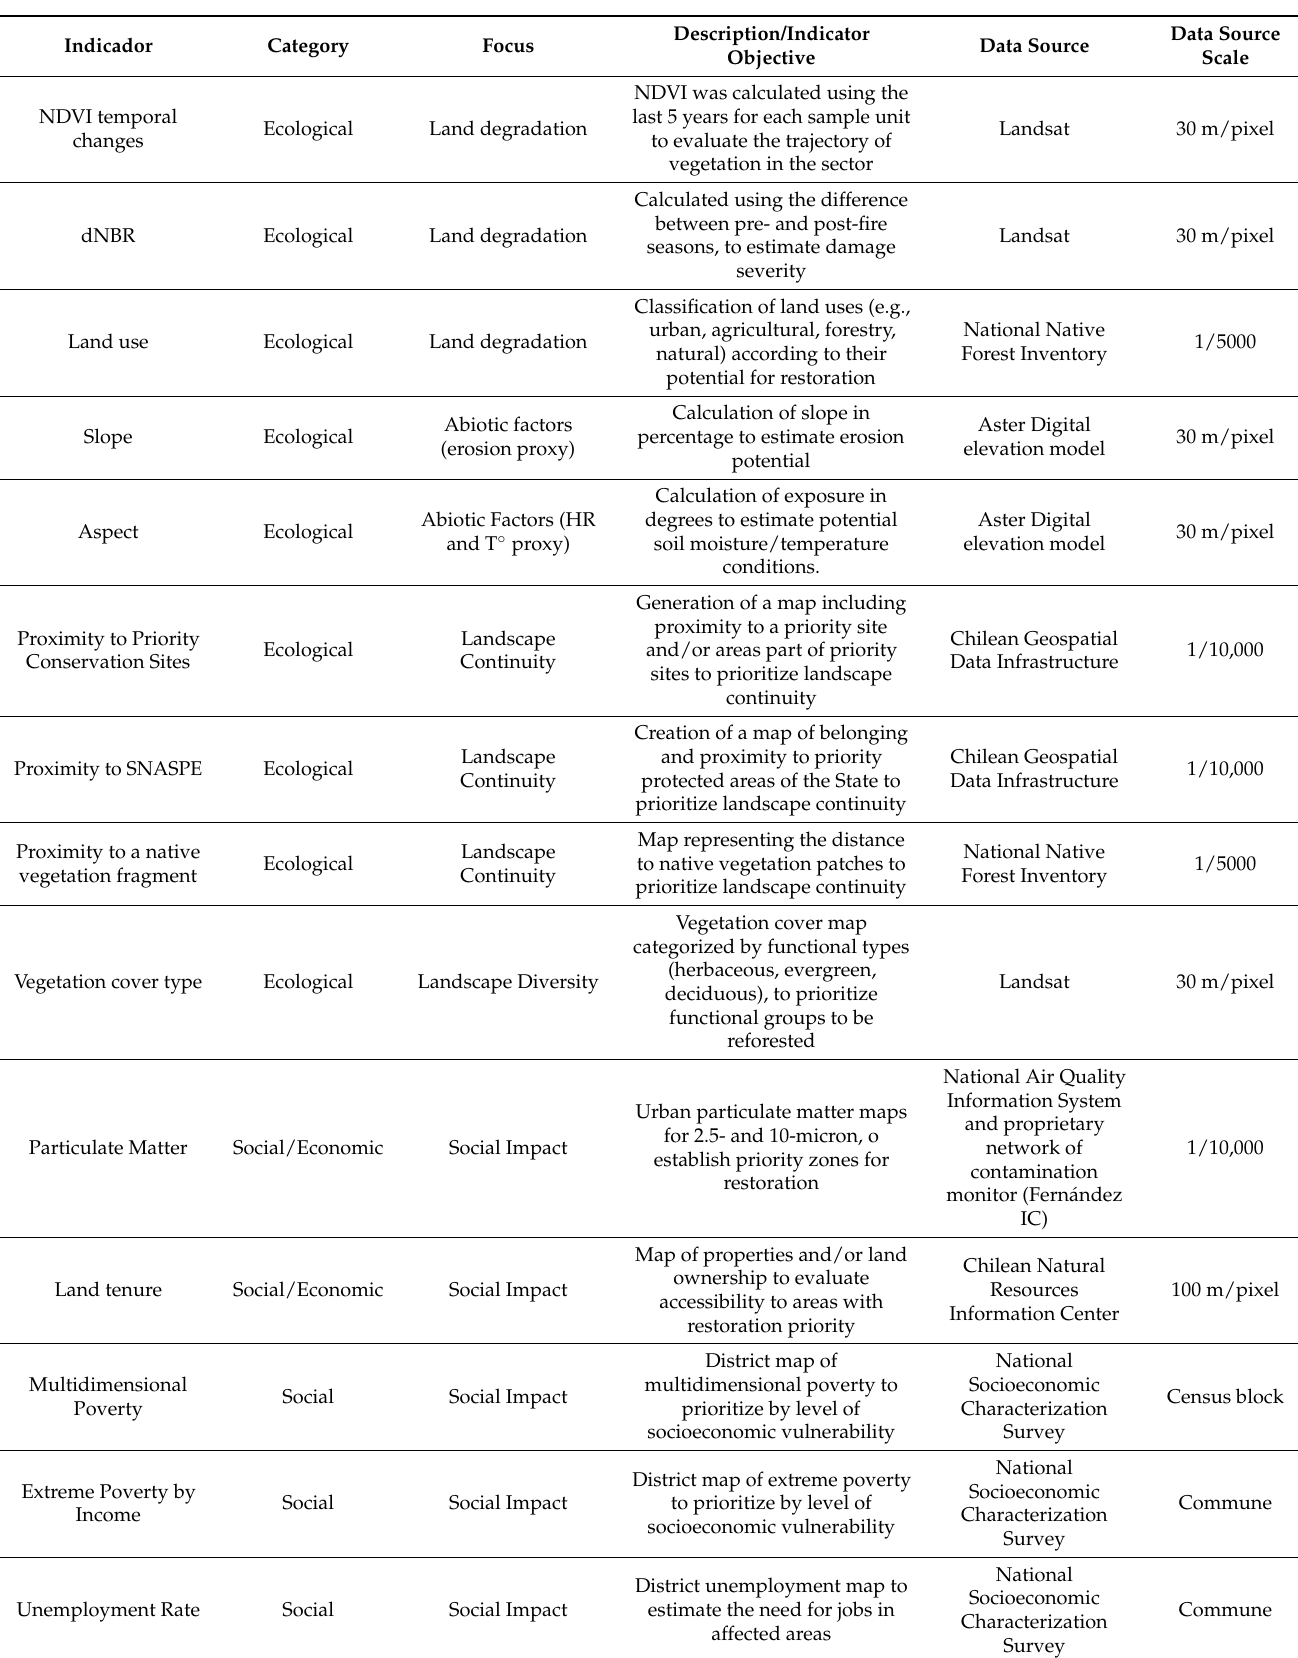
Table 3. General information about the indicators that a future version of the platform will